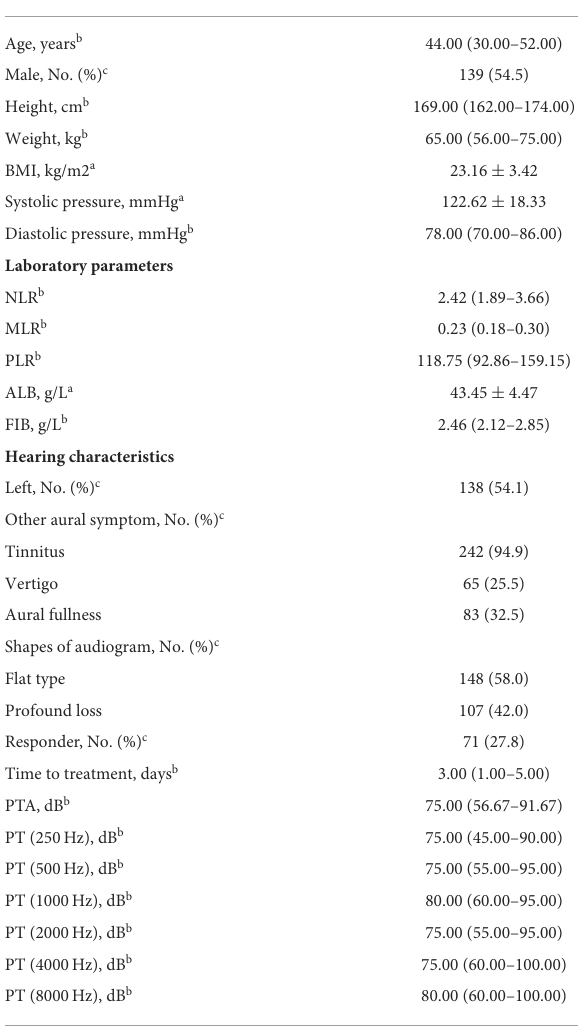
TABLE 1 Demographics, laboratory and hearing characteristics of